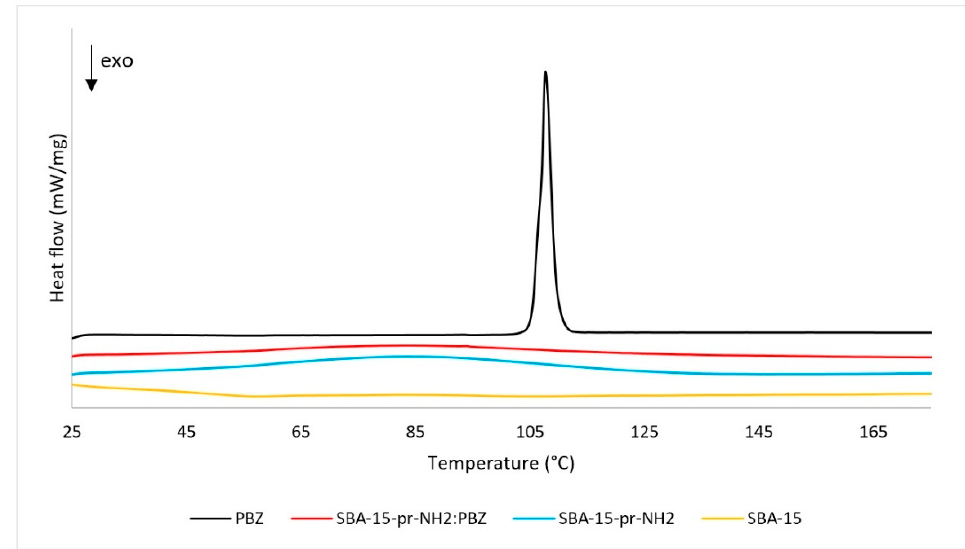
Figure 2. DSC thermograms of PBZ, SBA-15, SBA-15-pr-NH 2 :PBZ, and SBA-15-pr-NH 2 .